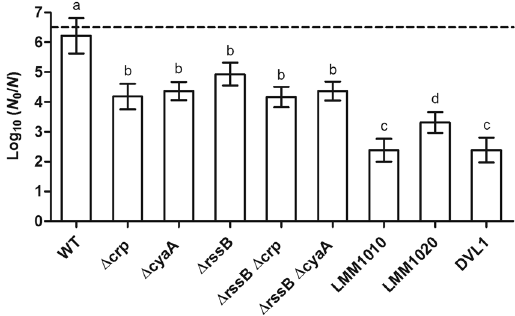
Figure 5. Logarithmic reduction factor of E. coli MG1655 WT and indicated mutants by a HHP treatment at 800 MPa for 15 min. The dotted line represents the quantification limit (1, 000 CFU/ml). Letters indicate statistically significant differences ( P ≤ 0.05) among the inactivation of all